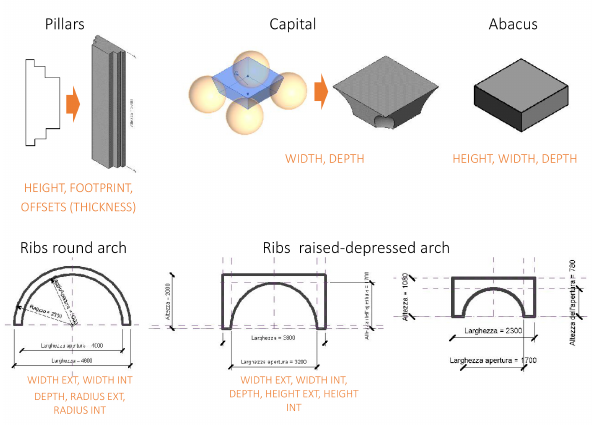
Figure 4. Parametric objects crated for the Santa Maria di Portonovo 3D Model in